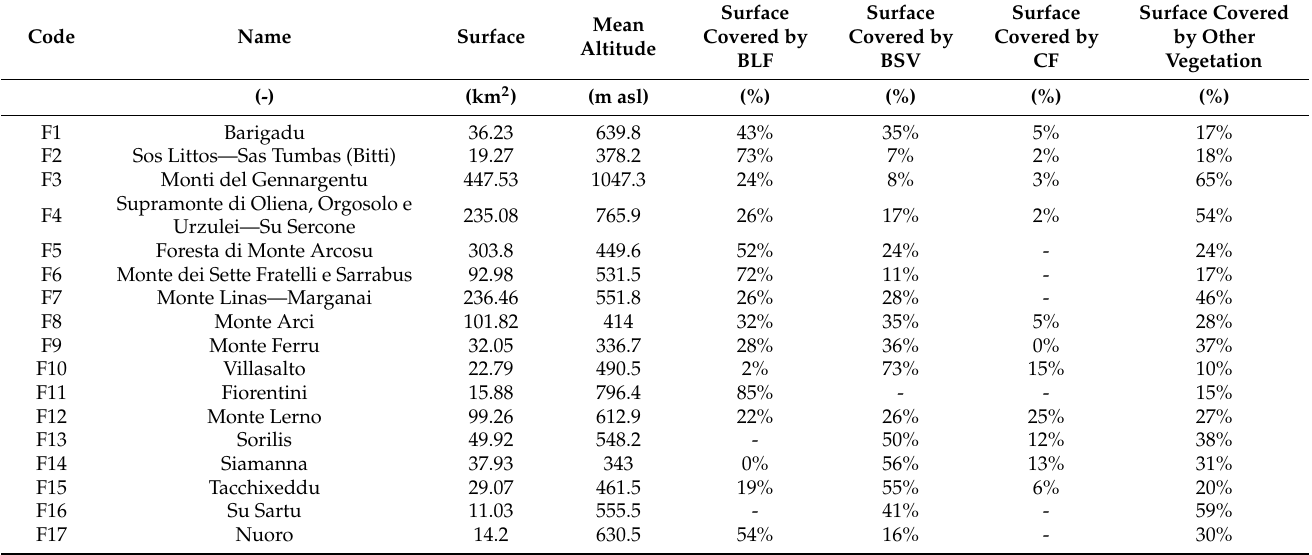
Table 2. Properties of the 17 Sardinian forests indicated in Figure 1: code; name; surface; mean altitude; and percentage of the surface covered by broad-leaved vegetation (BLF), bushy sclerophyllous vegetation (BSV), coniferous forest (CF), and other